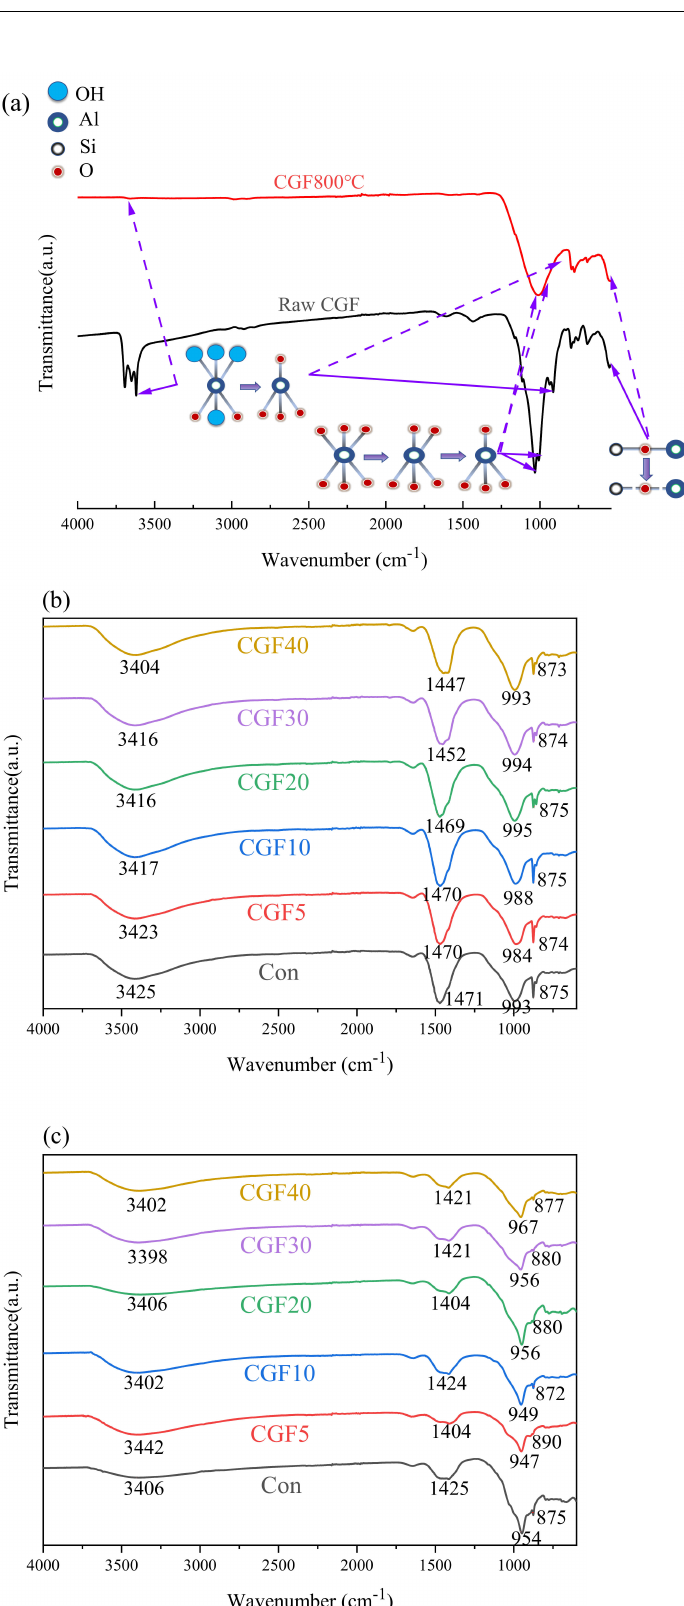
Figure 5. FT-IR spectrum of AAC: ( a ) comparison results of FTIR patterns of metakaolin; ( b ) 3 d; and ( c ) 28